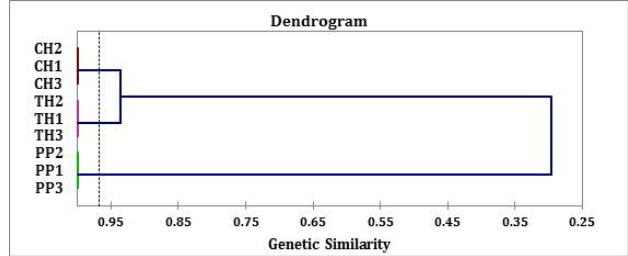
Fig. 6: The dendrogram of A. sativum L. of the Thai (TH), Chinese (CH) and Pingpong (PP) cultivars derived by UPGMA from the similarity matrix of the RAPD